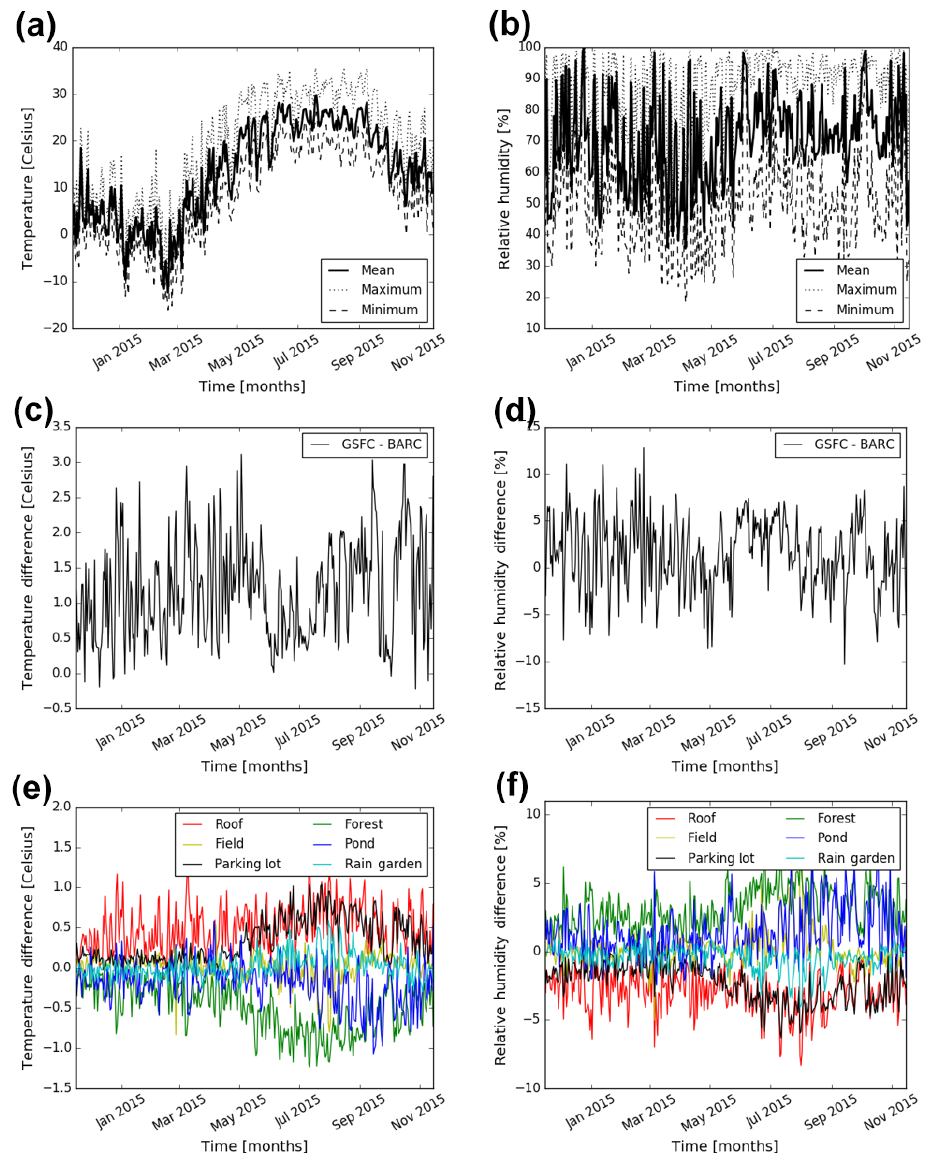
Figure 4. Plot of logger data for year 2 of data collection from November 2014 to November 2015. Figures in the left column show temperature features in degrees Celsius while figures on the right show relative humidity in